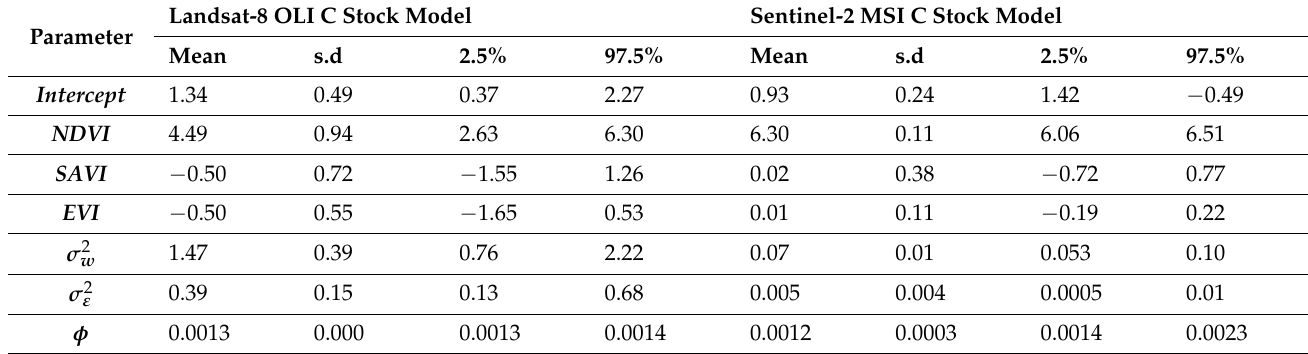
Table 2. Landsat-8- and Sentinel-2-derived predictors of C stock. NDVI =Normalised Differ- ence Vegetation Index; SAVI = Soil-Adjusted Vegetation Index; EVI = Enhanced Vegetation Index; σ 2 w = spatially structured variance; σ 2 ε = White noise; φ = spatial decay